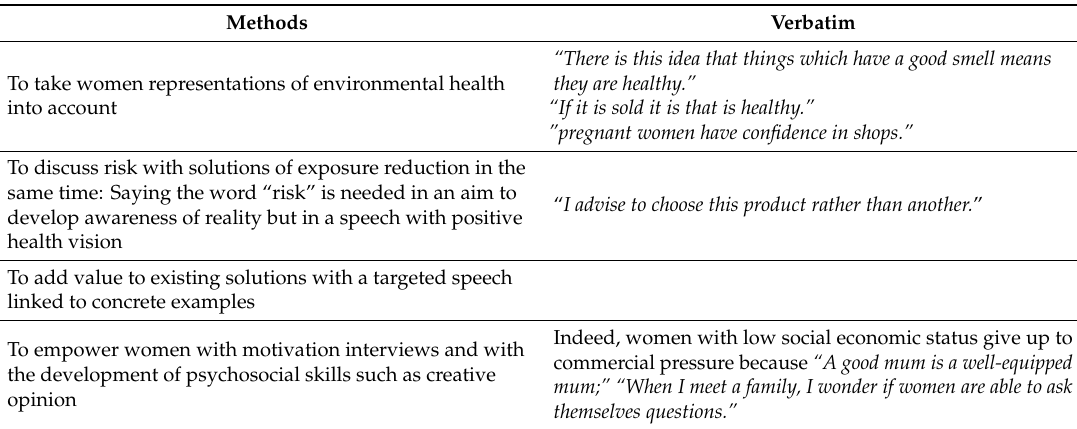
Table 4. Methods to discuss environmental health